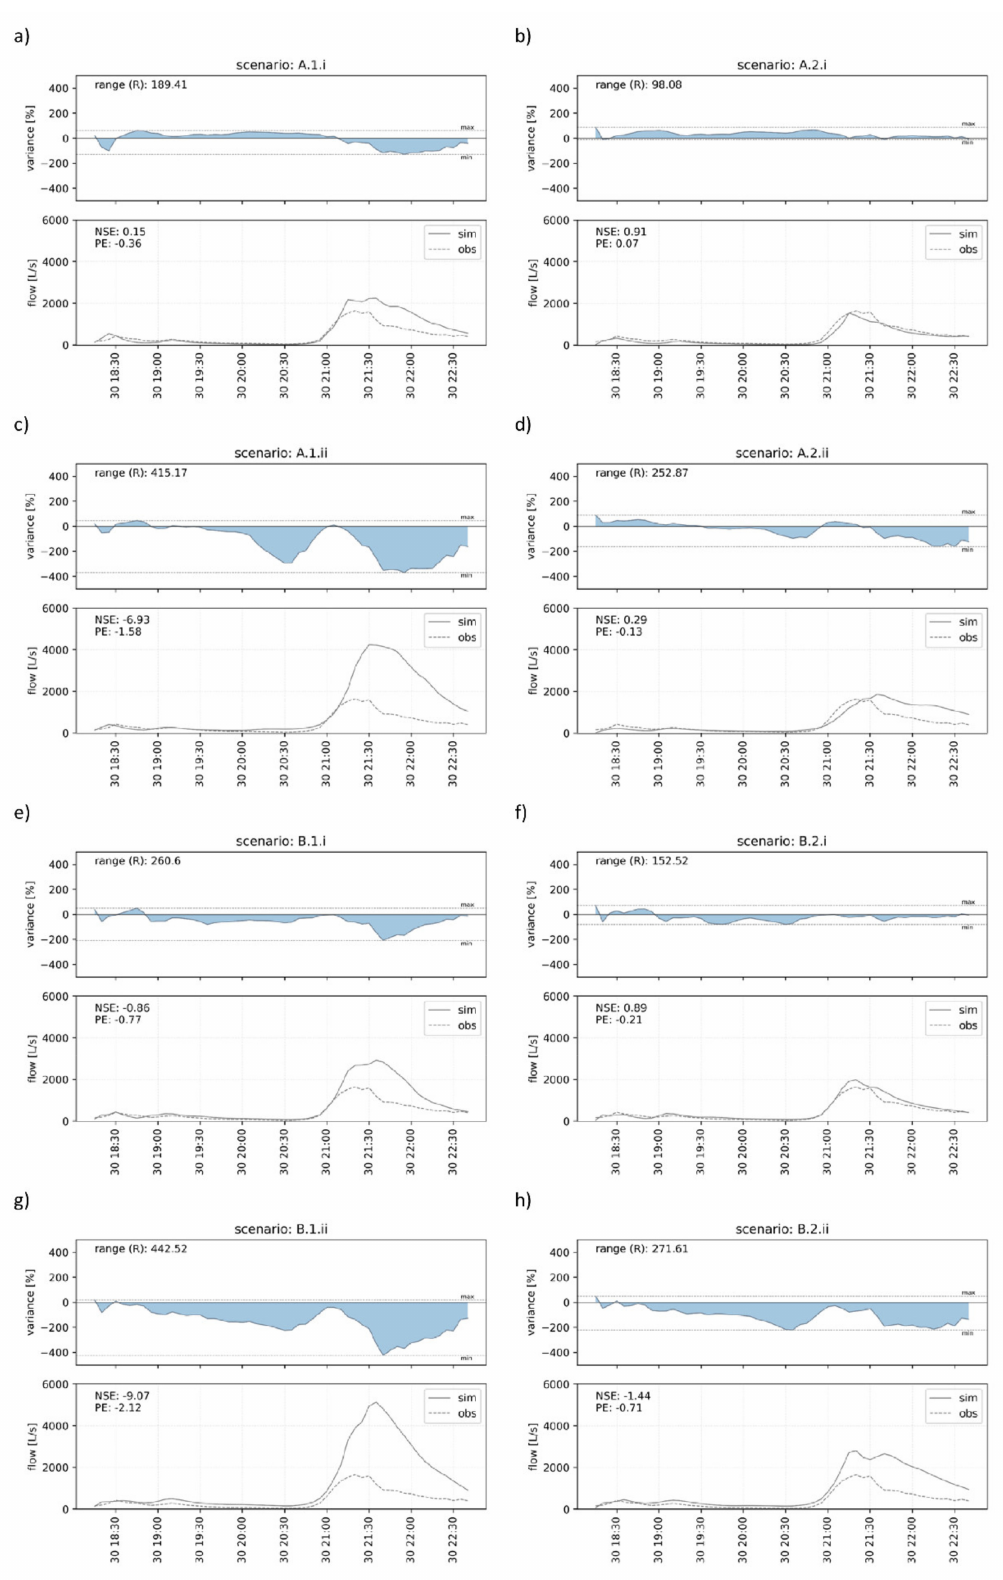
Figure 8. Range of relative deviation (R s ) for the model variable flow to estimate UC k of each scenario ( a – h ) for the identification of the most impact uncertainty source and NSE and the PE to evaluate the model performance of each